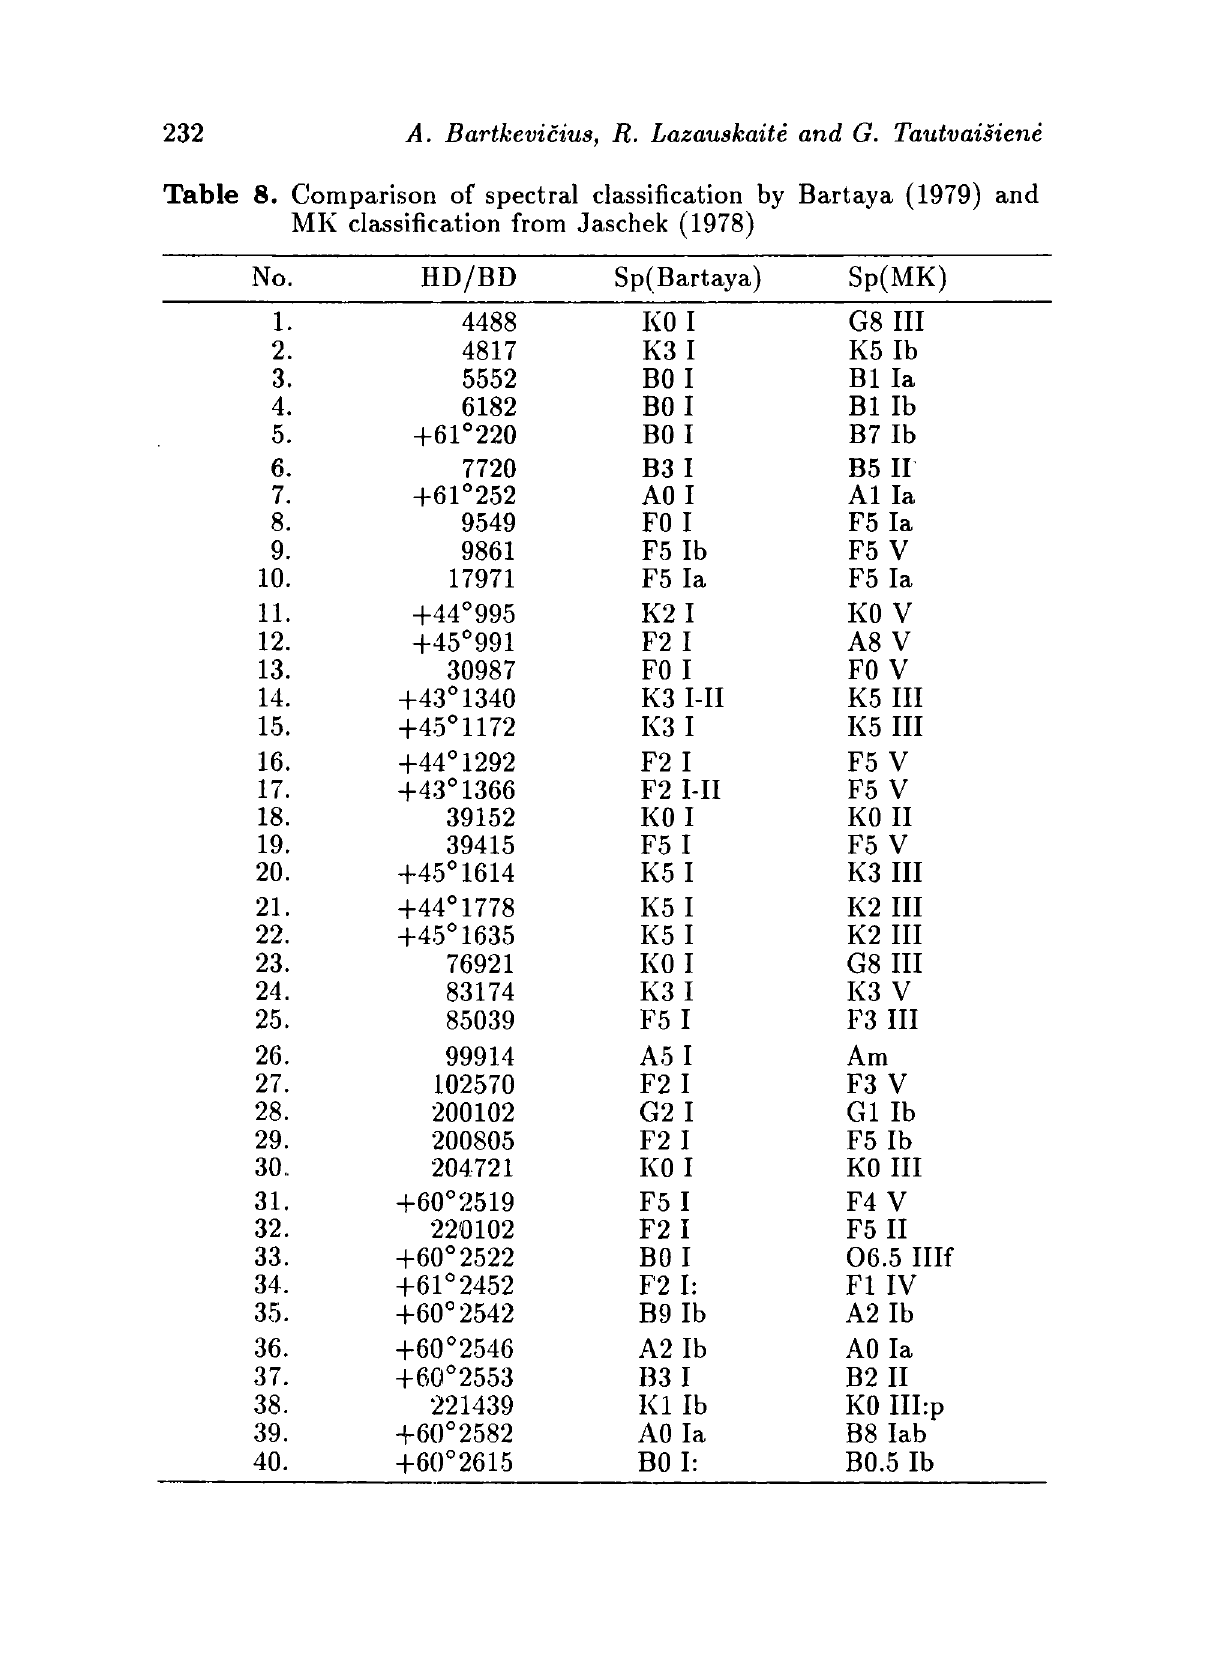
Table 8. Comparison of spectral classification by Bartaya (1979) and MK classification from Jaschek (1978)